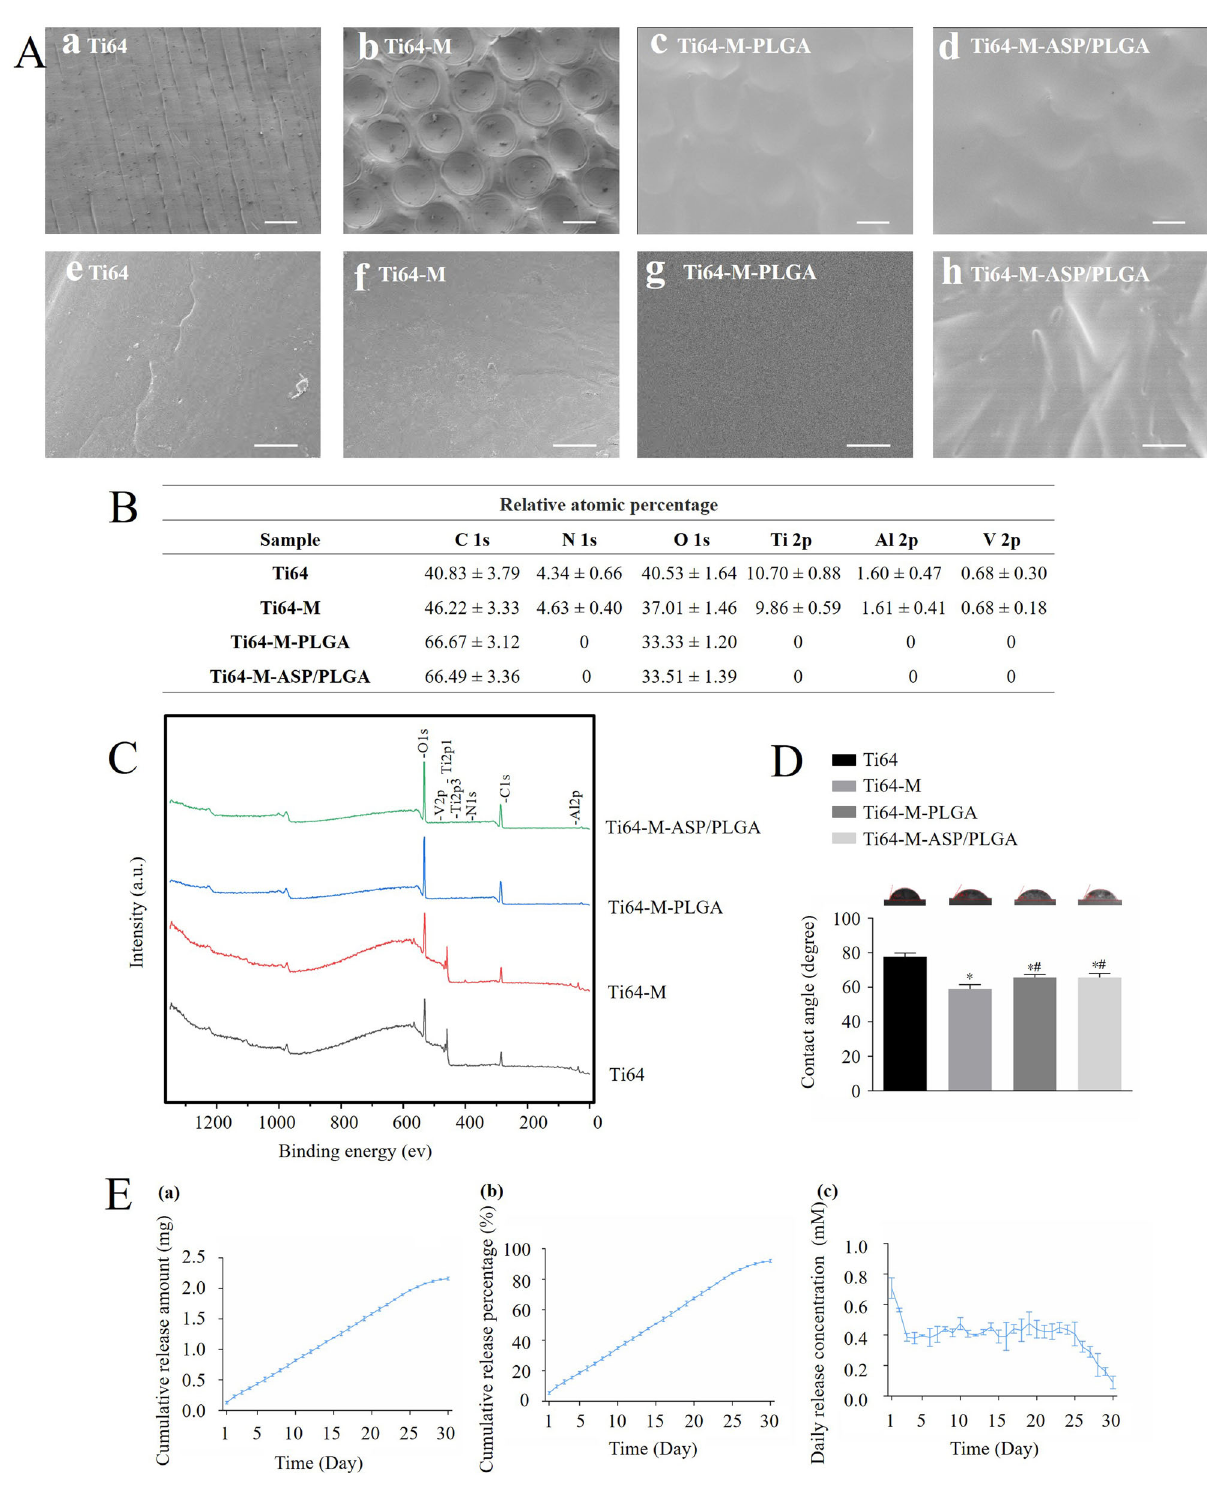
Fig. 2 Surface morphology, chemical composition, hydrophilicity and ASP release pro fi le observation. A SEM images of different samples. Figure e – h are the magni fi ed SEM pictures of a – d, respectively. Scale bars indicate 300 µm (a – d) and 10 µm (e – h), respectively. B , C XPS results of different samples. D Contact angle measurement of different